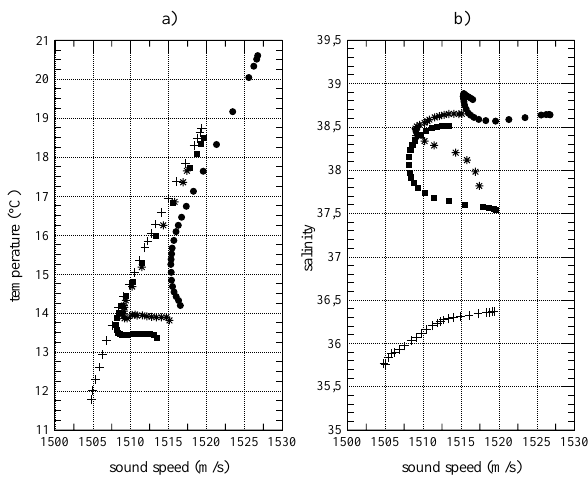
Fig. 1. Scatter plot of areal annual means in the North Atlantic (+), West Mediterranean ( (cid:4) ), East Mediterranean ( • ) and Adriatic Sea ( ∗ ), between 5 and 500m of (a) temperature ( ◦ C) and sound speed (m/s) and (b) salinity and sound speed